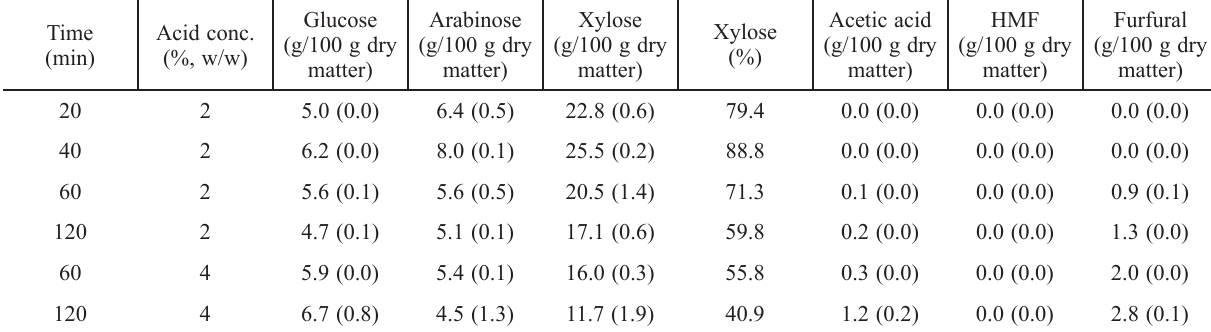
Table 3 – Reaction conditions, total sugar yields and degradation component yields of corn stover hydrochloric acid hydrolysis at 120 °C. Standard deviations are calculated from duplicates. HMF: hydroxymethylfurfural. Time